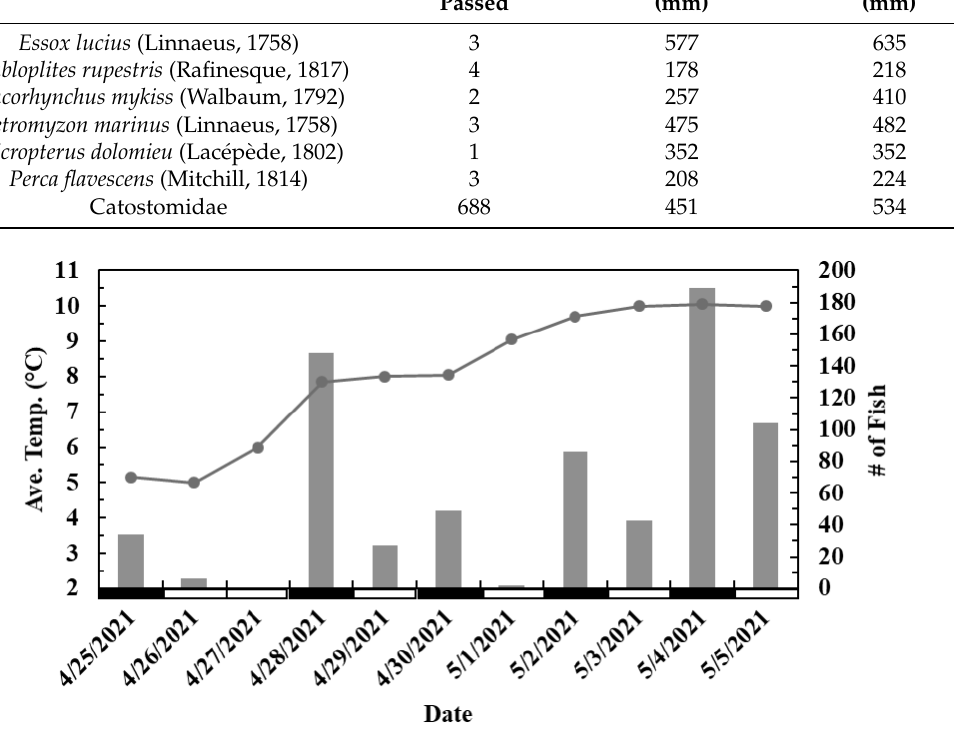
Figure 6. Plot of daily average water temperature and number of suckers transported by the ASFL. Line indicates water temperature, bars indicate number of suckers transported by the ASFL, and rectangles along the x – axis indicate whether the attraction flow was on (black) or off (white). Non-sucker fish species transported by the ASFL included four game fishes native to the Great Lakes, rainbow trout, and invasive sea lamprey (Table 2). Several fish species known to be in the pre-trap crowding structure during the ASFL trials (based on fishes identified to species captured in the sea lamprey pot-style traps) were not transported by the ASFL. In order of most to least abundant, these included the emerald shiner ( Notropis atherinoides (Rafinesque, 1818)), walleye ( Sander vitreus (Mitchill, 1818)), round goby ( Neo- gobius metanostomus (Pallas, 1814)), troutperch ( Percopis omiscomaycus (Walbaum, 1792)), common shiner ( Luxilis cornutus (Mitchill, 1817)), creek chub ( Semotilus atromaculatus (Raf- inesque, 1820)), brown trout ( Salmo trutta (Linnaeus, 1758)), and rainbow smelt ( Osmerus mordax (Mitchill, 1814)). Table 2. Total count and average and maximum length of fish transported by the ASFL during the entire test period. Note, only 169 (25%) of the suckers caught were measured for total length. Species